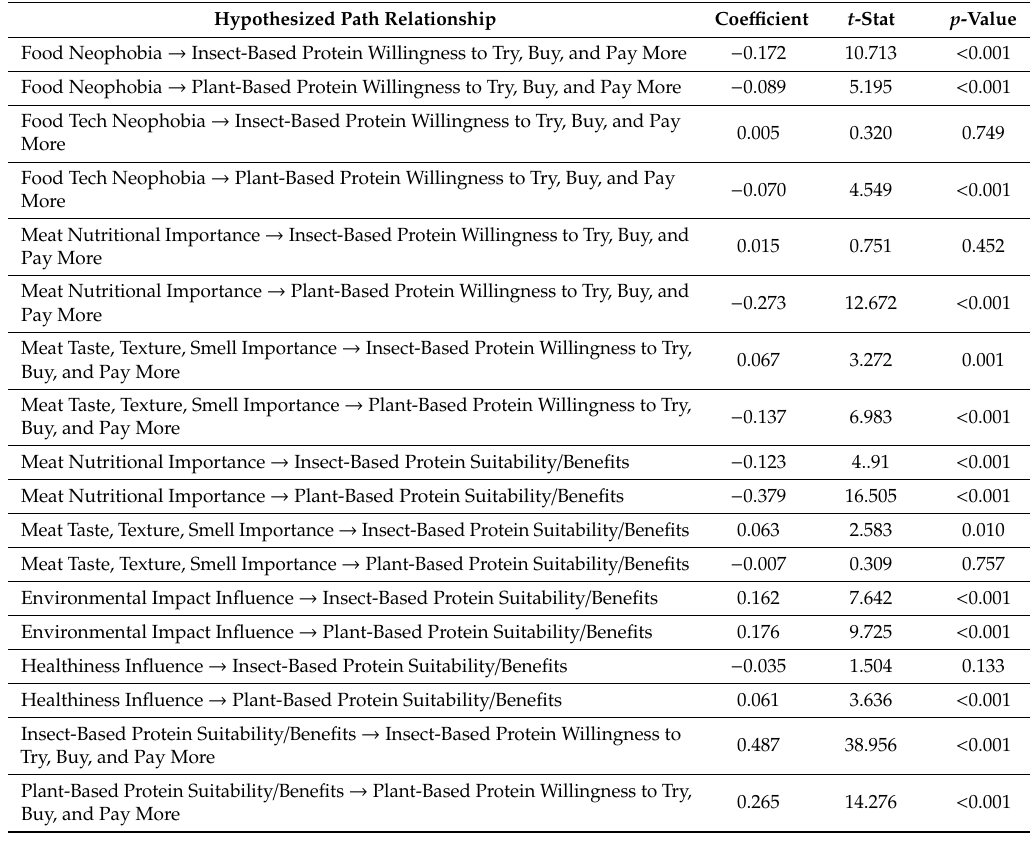
Table 5. Direct Path Coe ffi